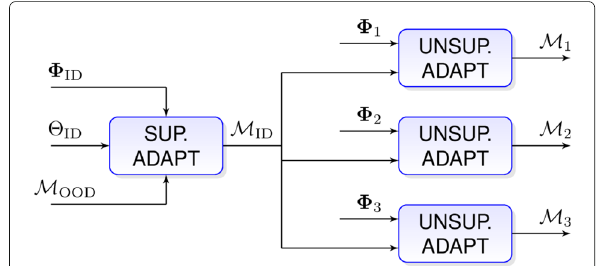
Fig. 10 Semi-supervised adaptation strategy based on the unsupervised independent adaptation approach for the episodes 1, 2, and 3. M OOD represents the out-of-domain model, M ID depicts the show in-domain model, and M 1 , M 2 , and M 3 the adapted models for each episode. (cid:4) ID and (cid:6) ID symbolize the in-domain i-vectors and its speaker labels. (cid:4) 1 , (cid:4) 2 , and (cid:4) 3 are the i-vectors from each episode